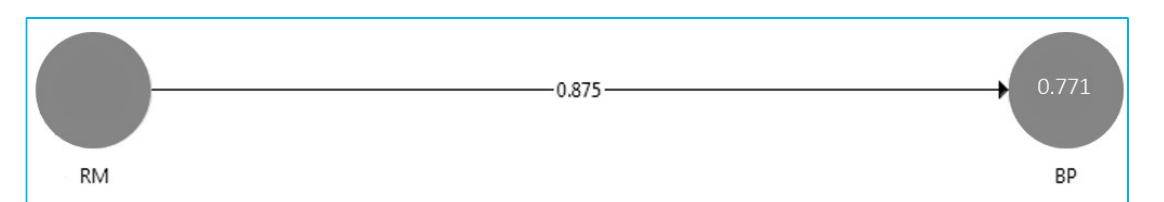
Fig. 2. Collective RM practices and banks’ performance path